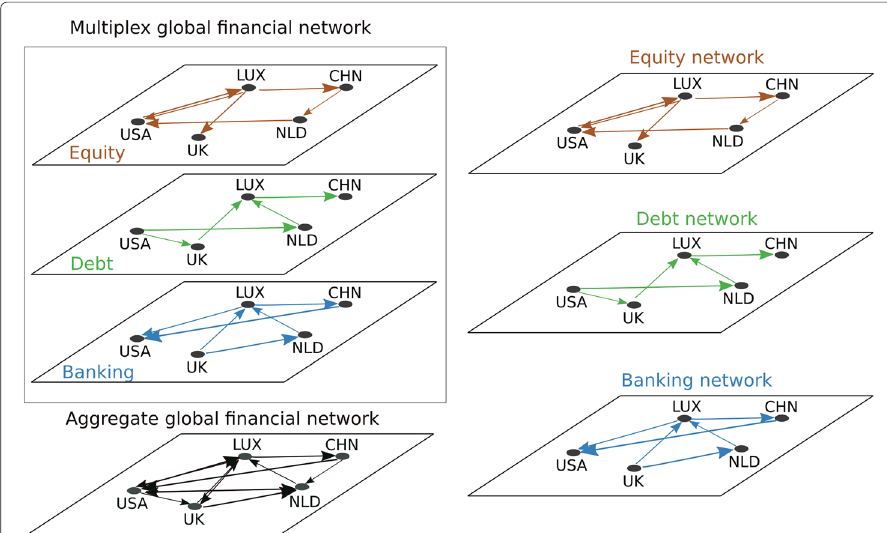
Fig. 1 Global financial networks. Schematic representations of the networks that we construct using IMF data. In all networks, nodes represent countries and edges encode cross-country financial assets. The multiplex network has three layers, which correspond to three types of assets: equity (layer 1), debt (layer 2), and banking loans and deposits (layer 3). The multiplex network has no interlayer edges, so it is an edge-colored